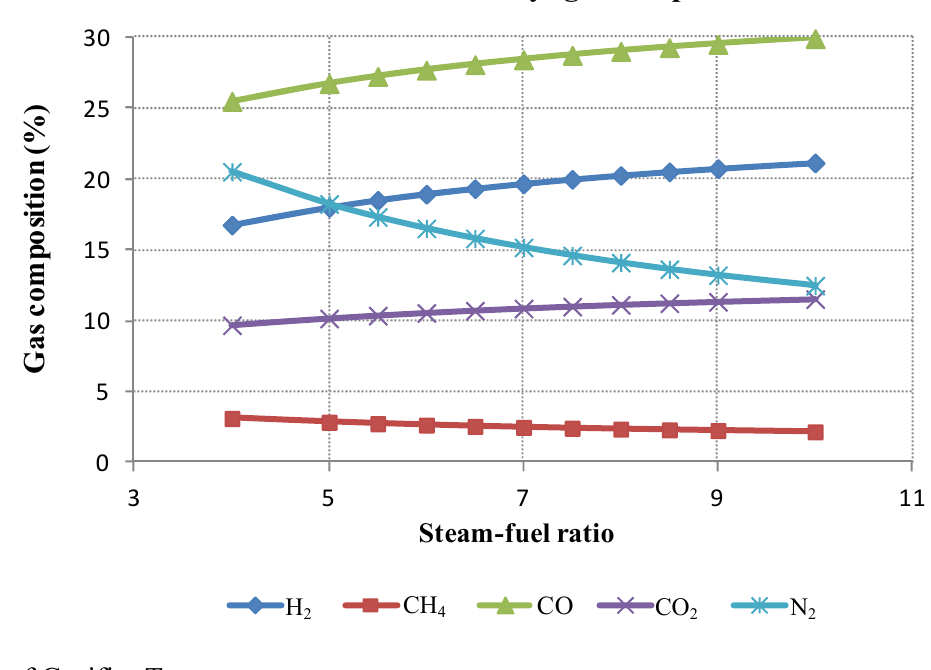
Figure 6. Effect of steam-fuel ratio on syngas